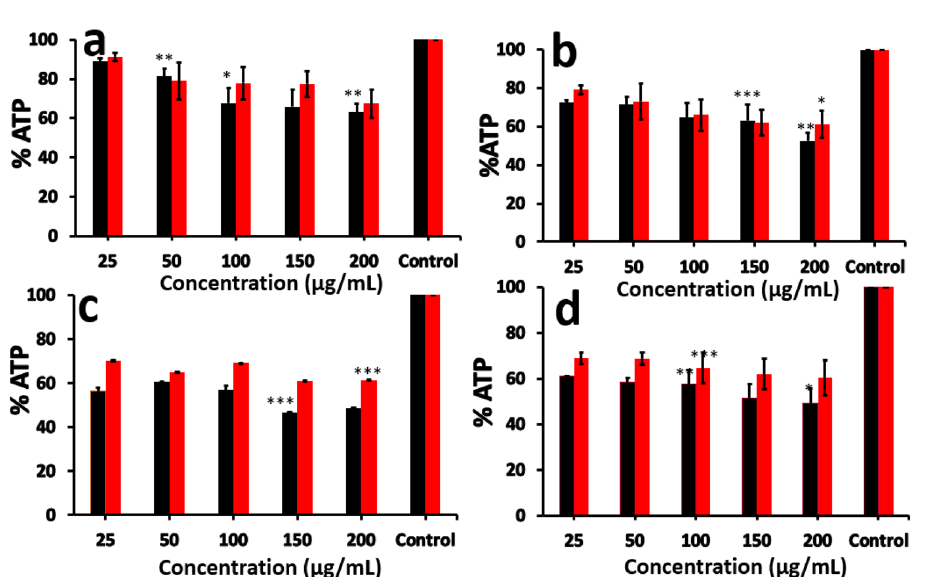
Figure 8. Intracellular concentration of ATP after exposure to PVC ( ■ ) and PMMA ( ) NPs at different concentrations for ( a ) 24 h, ( b ) 48 h, ( c ) 96 h and ( d ) 120 h. The data for 72 h incubation is given in the supporting information, Figure S8. The results are given as % ATP level with respect to control (untreated cells) and are represented as the mean ± SEM of three experiments. Statistical analysis was done by one-way ANOVA (* p < 0.05, ** p < 0.01, *** p < 0.001, **** p < 0.0001) compared to control (untreated